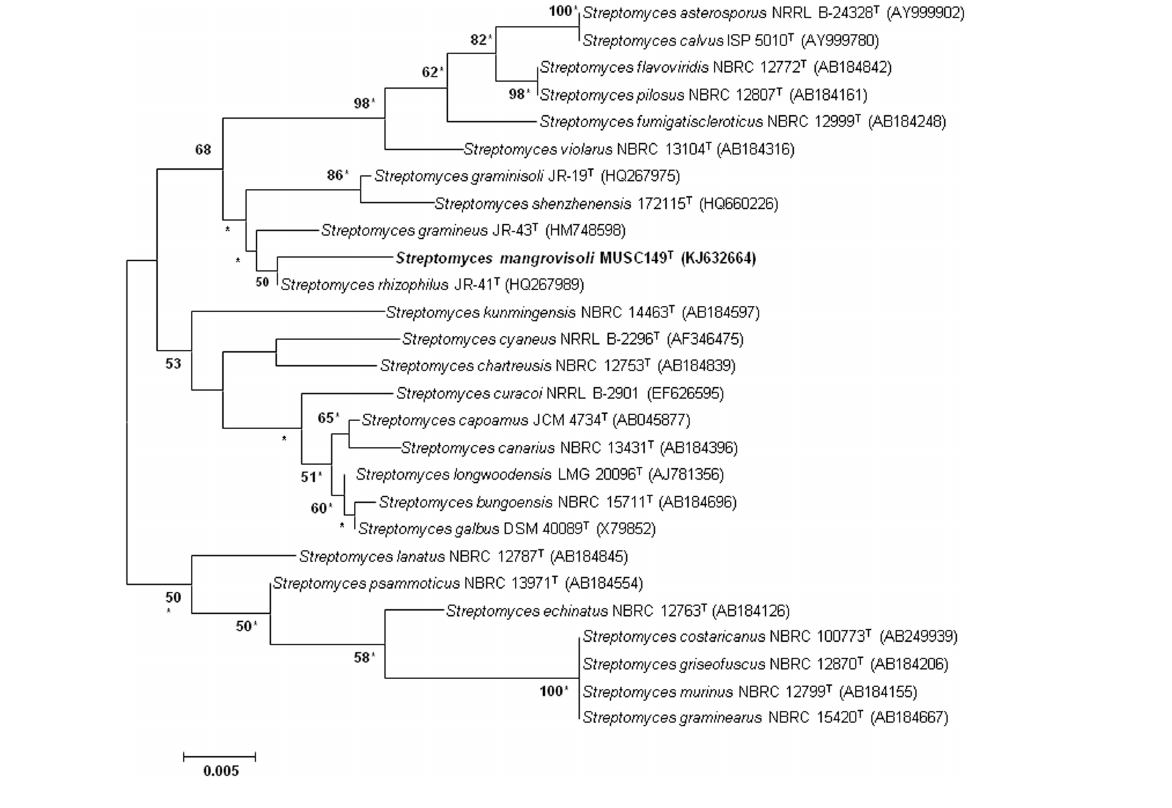
1000 bootstrap re-samplings, only values above 50% are shown. Bar, 0.005 substitutions per site. Asterisks indicate that the corresponding nodes were also recovered using the neighbor-joining tree-making algorithm.